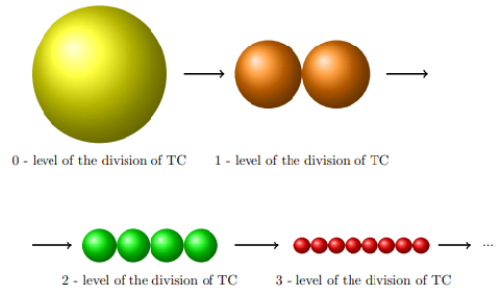
Figure 13. The levels of the division of TC.